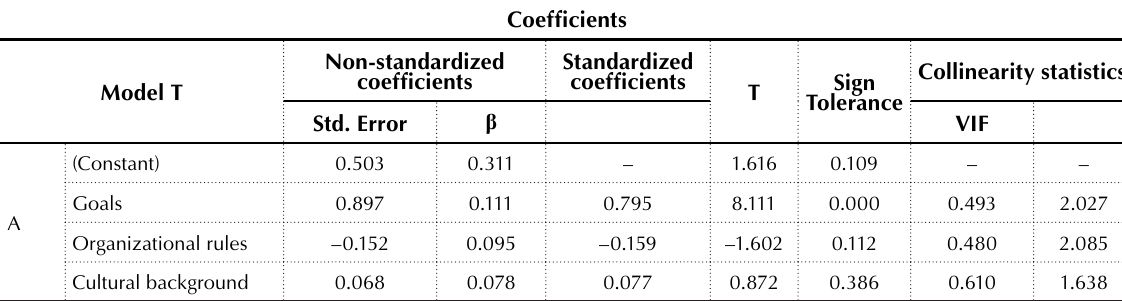
Table 11. T-test and estimation of regression coefficients for model